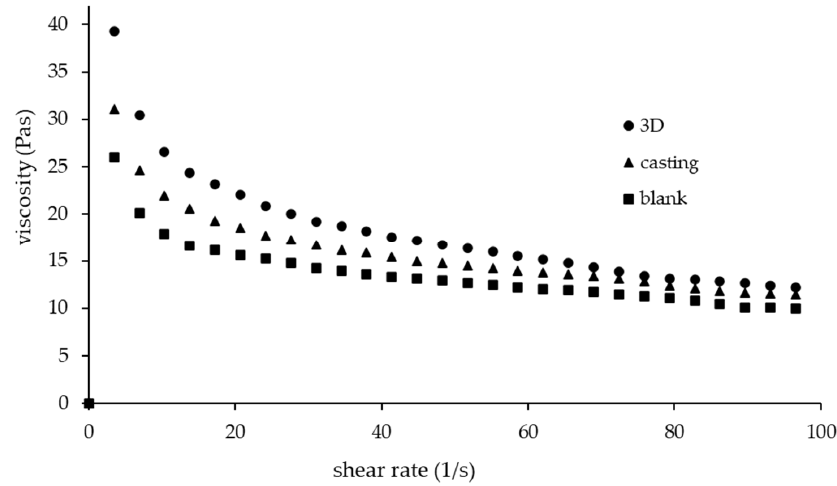
Figure 2. Rheological characteristics of HPMC E15 in different formulations: graph plotted between viscosity and shear rate with fitting power ‐ law model. Table 1. Parameters from power ‐ law model and shape fidelity factor.